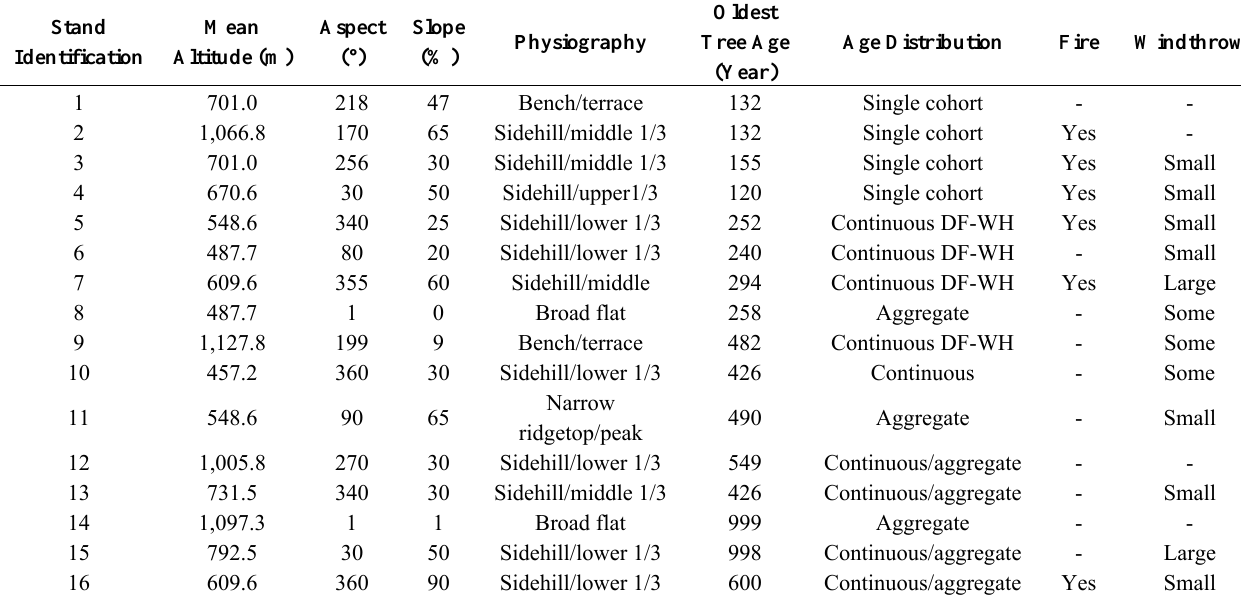
Continuous DF-WH = continuous in total, DF (Douglas-fir) in older age groups and western hemlock